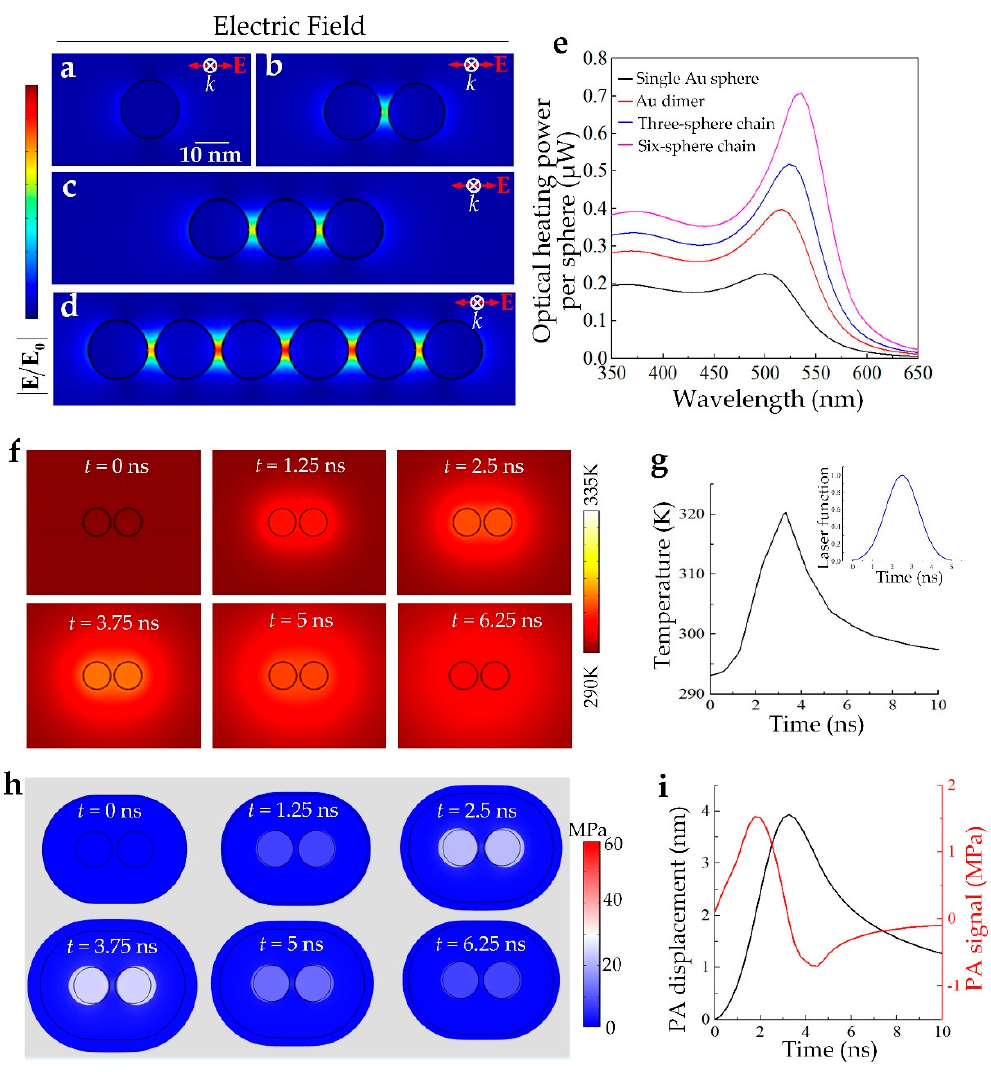
Figure 2. ( a – d ) Localized surface plasmon resonance (LSPR)-induced electric field enhancement for gold nanochains (GNCs) with different chain lengths; ( e ) Calculated absorbed power as a function of laser wavelengths for GNCs with different chain lengths; ( f ) Thermal fields of the GNCs with time. The zero time point is the starting time point of the laser pulse; ( g ) The temperature of the gold nano-dimer as a function of time; ( h ) Thermal expansion induced stress of the GNCs and surroundings; ( i ) The resulting PA displacement and signal from the GNCs and